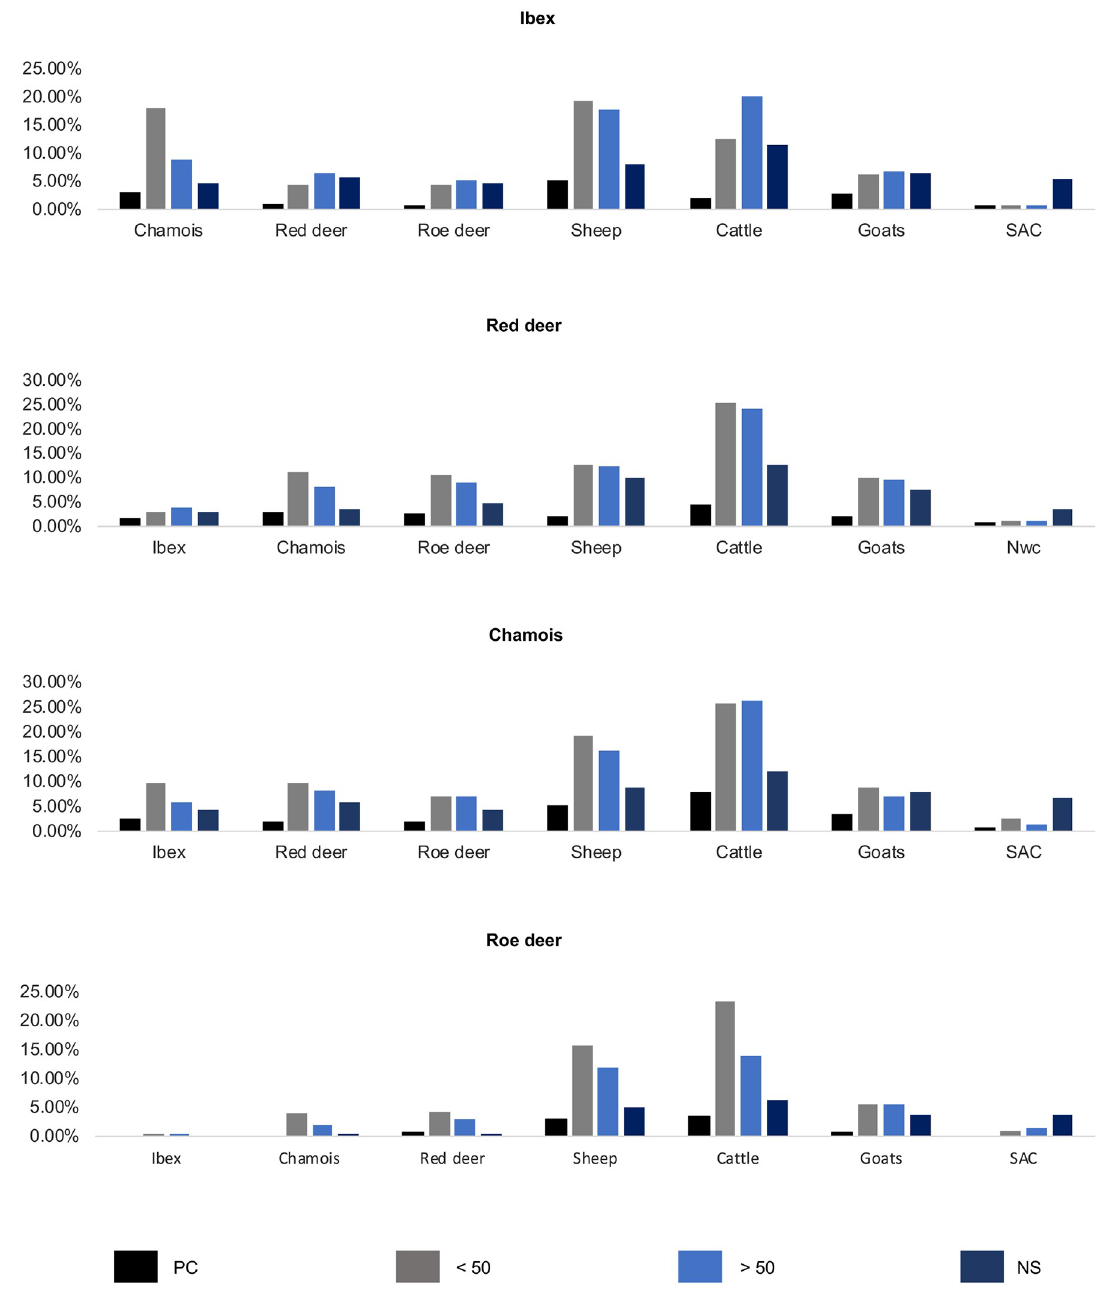
Fig 4. Relative frequency of observations of different types of interspecies contacts between wild and domestic ruminants in Switzerland. Proximity between species: 100% relates to all samples collected (information from respondents who did not report observations and lacking information due to non-reporting are not included in the graph). Colored bars indicate the following types of interactions: PC: physical contact; < 50 m: encounter of < 50 m; > 50 m: encounter of > 50 m; NS: non-simultaneous occupation of the same